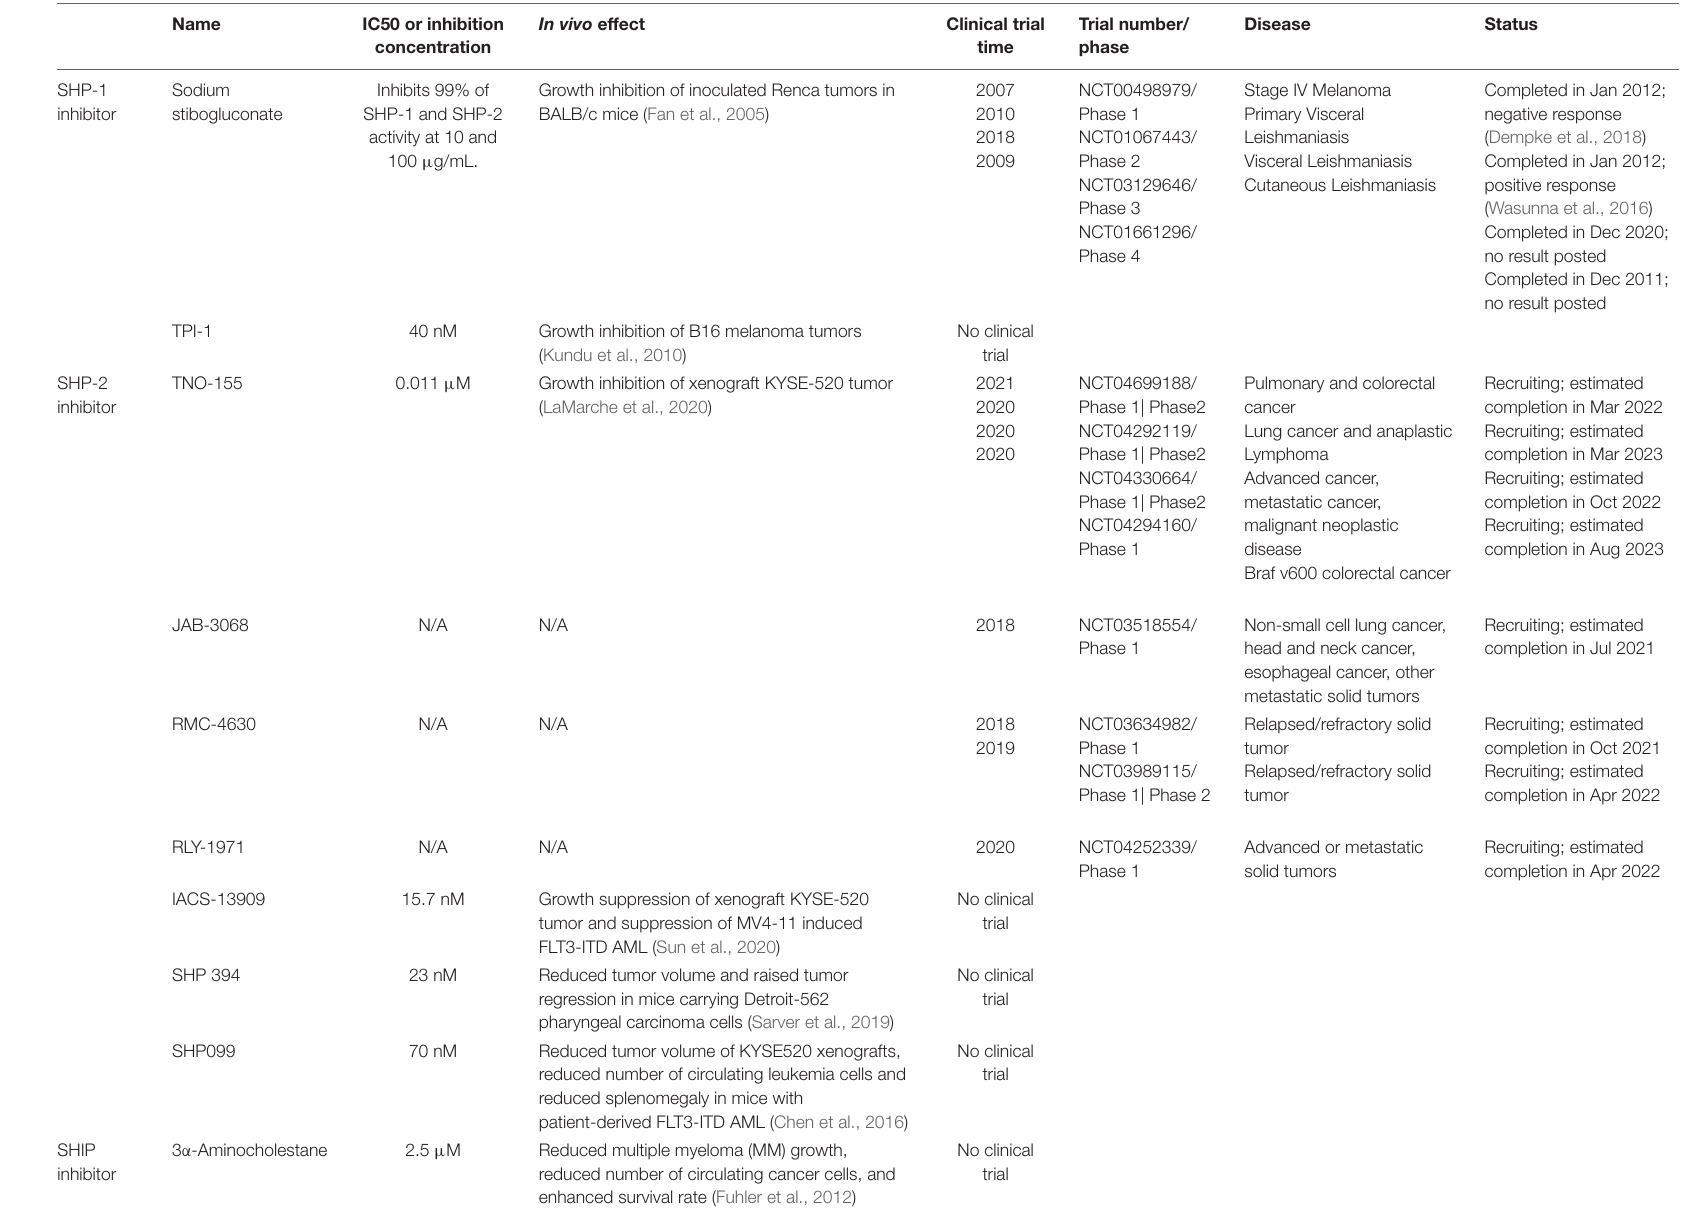
TABLE 2 | SHP and SHIP inhibitors with clinical trial or with tumor suppression effect in vivo